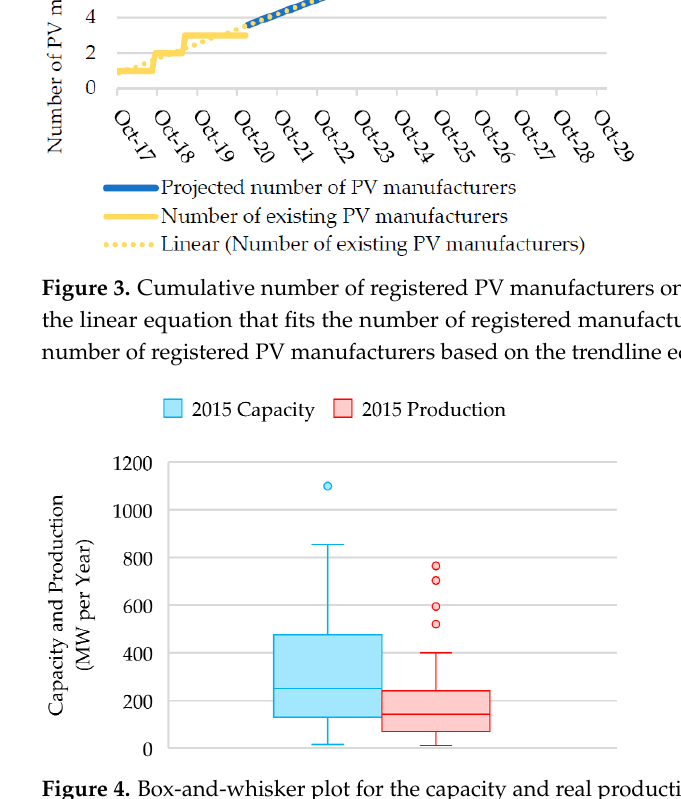
Figure 3. Cumulative number of registered PV manufacturers on the REPDO portal [12] (gold line), the linear equation that fits the number of registered manufacturers (gold dots) and the projected number of registered PV manufacturers based on the trendline equation (blue line).